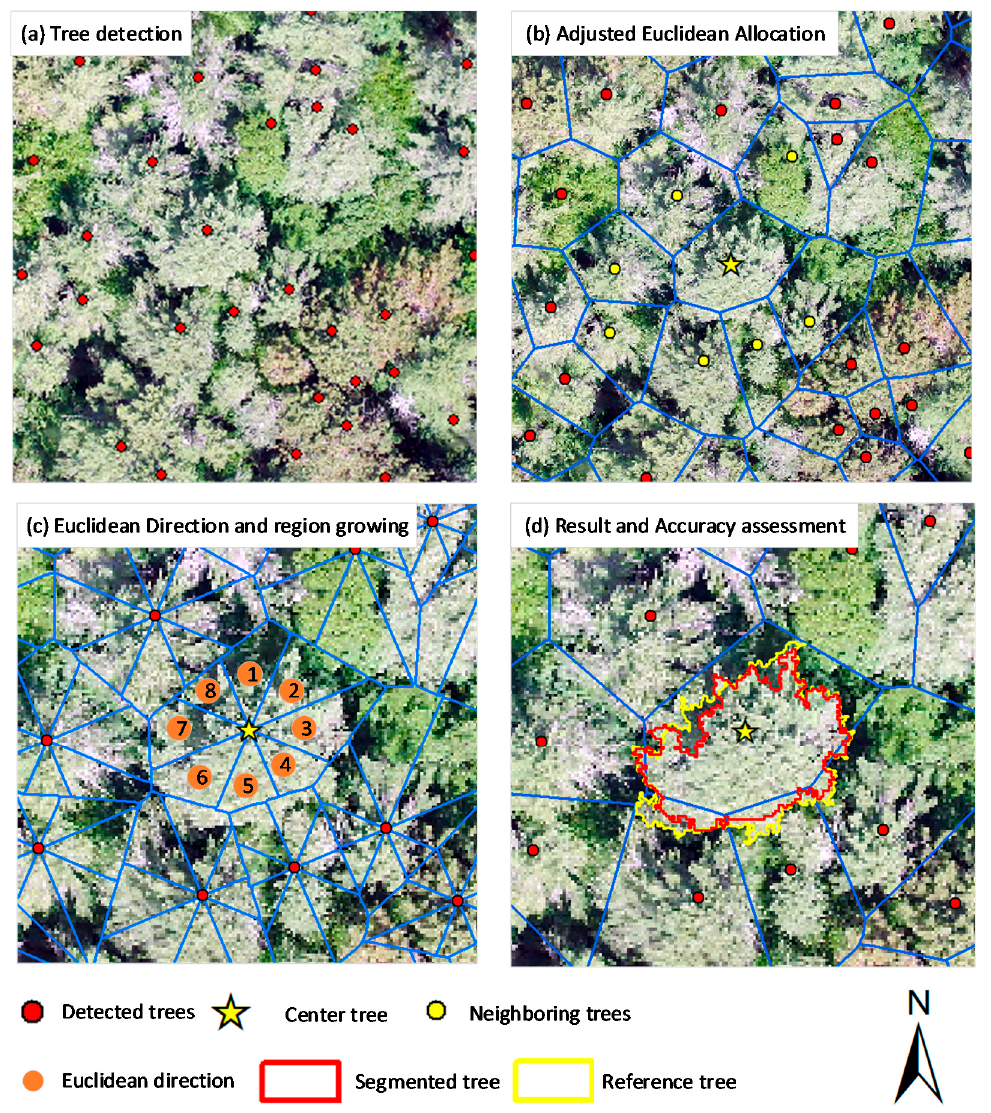
Figure 1. Workflow of the method: (a) Tree detection; (b) Adjusted Euclidean allocation; (c) Euclidean direction and region growing; (d) Result and accuracy assessment.